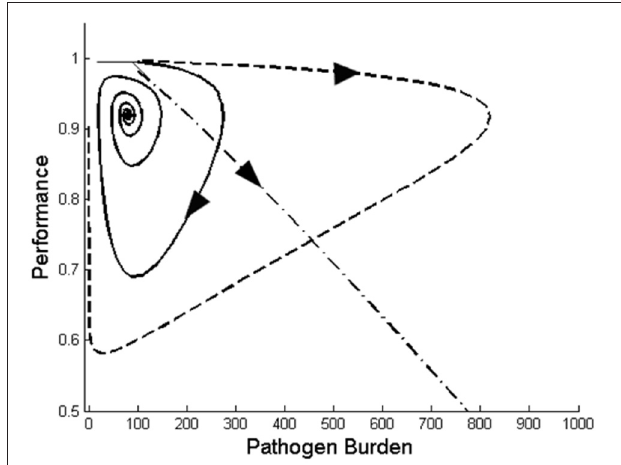
FIGURE 4 | Three different types of performance vs . pathogen burden profiles generated by the mathematical dynamical system (7) for different values of the model parameters. The size of the arrows in this graph does not reflect the actual